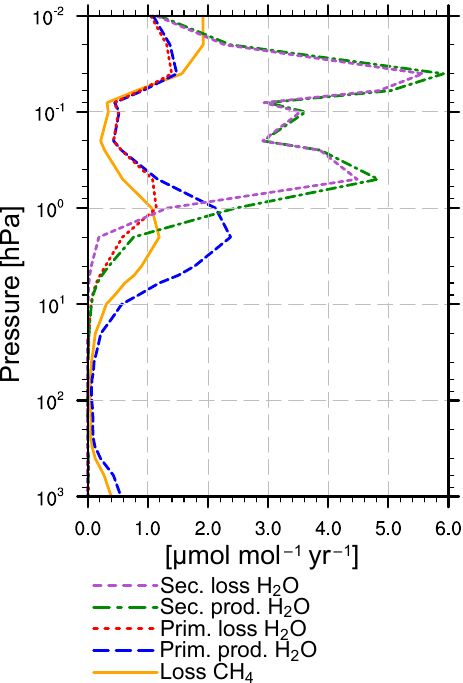
Figure 2. Separate loss of CH 4 , and primary and secondary loss and production of H 2 O from box model simulation